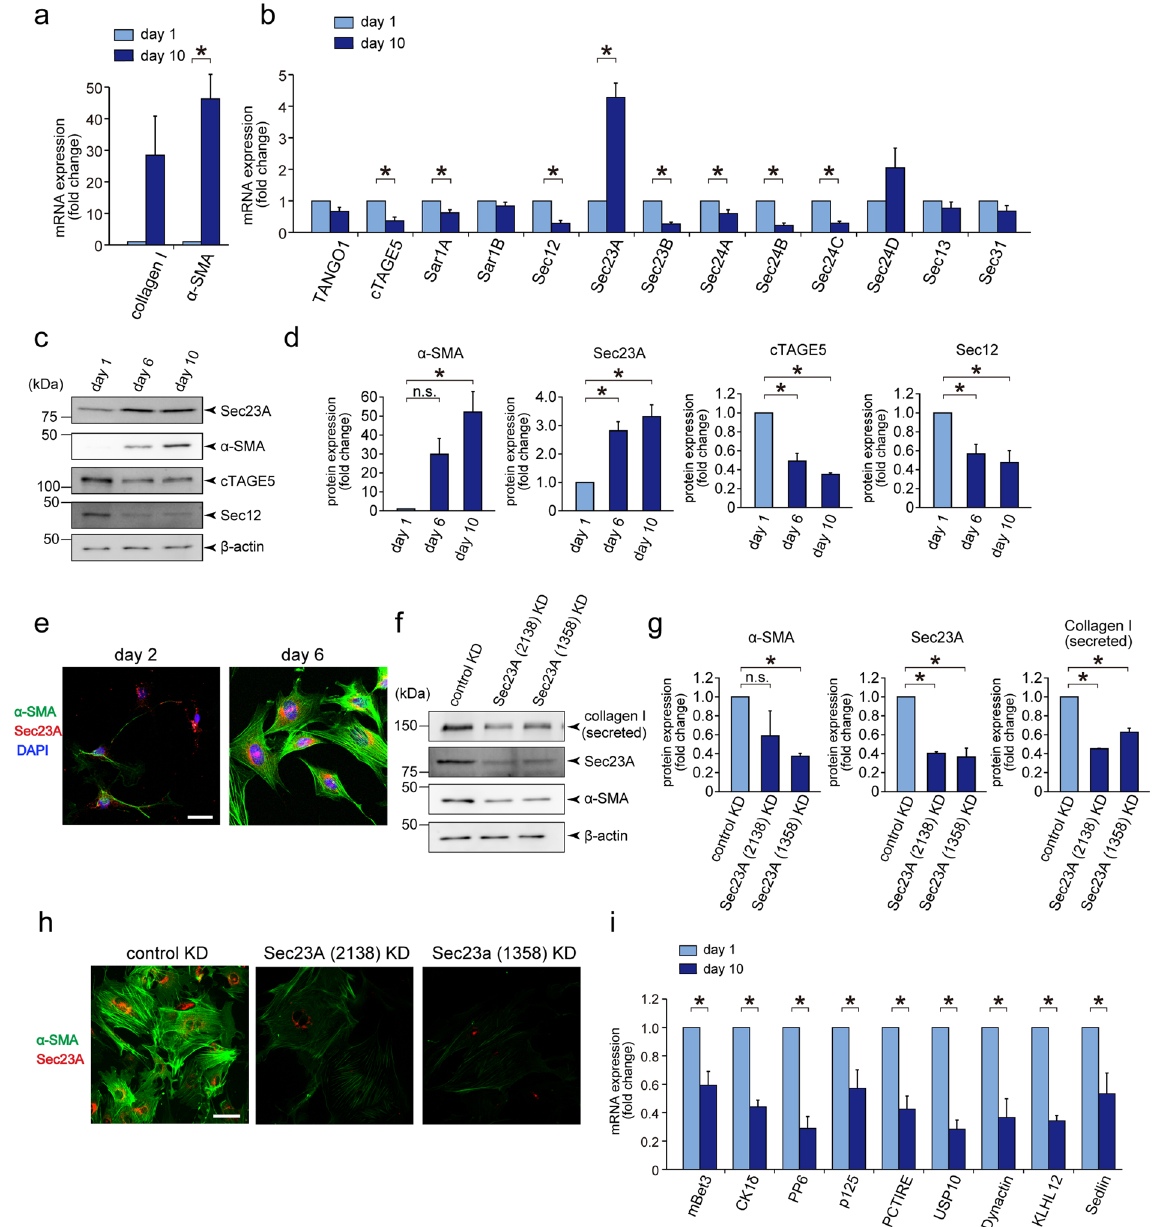
Figure 1. Sec23A is required for in vitro activation of primary rat HSCs. ( a and b ) Primary rat HSCs isolated by in situ perfusion were cultured for 1 to 10 days. Cells were collected for RNA extraction, followed by qRT-PCR ( n = 5). ( c and d ) Primary rat HSCs isolated by in situ perfusion were cultured for 1, 6 and 10 days. Proteins were extracted and analysed by SDS-PAGE, followed by western blotting with anti-Sec23A, anti- α -SMA, anti-cTAGE5, anti-Sec12 and anti- β -actin antibodies. ( c ) Representative immunoblots. ( d ) Quantification of immunoblots ( n = 3). The band intensities were normalized to those of β -actin. ( e ) Primary rat HSCs isolated by in situ perfusion were cultured for 2 to 6 days. Cells were fixed and stained with anti-Sec23A and α -SMA antibodies, and DAPI. Bars, 25 μ m. ( f and g ) Primary rat HSCs isolated by in situ perfusion were cultured for 2 days and transfected with the indicated siRNA(s). After 4 days, whole cell proteins were extracted and analysed by SDS-PAGE, followed by western blotting with anti-Sec23A, anti- α -SMA and anti- β -actin antibodies. Medium was collected and the proteins were precipitated for SDS-PAGE, followed by western blotting with anti-collagen I antibody. ( f ) Representative immunoblots. ( g ) Quantification of immunoblots ( n = 3). The band intensities were normalized to those of β -actin. ( h ) Primary rat HSCs isolated by in situ perfusion were cultured for 2 days and transfected with the indicated siRNA(s). After 4 days, cells were fixed and stained with anti-Sec23A and anti- α -SMA antibodies. Bars, 50 μ m. ( i ) Primary rat HSCs isolated by in situ perfusion were cultured for 1 to 10 days. Cells were collected for RNA extraction and qRT-PCR ( n = 5). Error bars represent mean ± SEM. * P < 0.05. Uncropped original blots were shown in Fig.